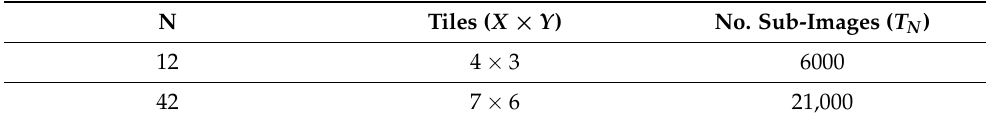
Table 1. Two values of N divide an image from the CFDB dataset into different set of tiles, which results in different numbers of sub-images per N . N